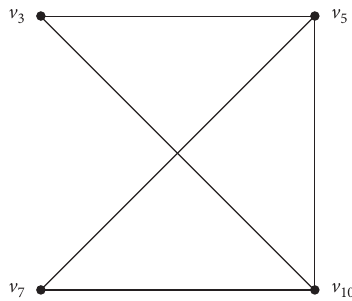
Figure 2: Graph G I ( Λ ), where Λ = < 3, 5, 7 > and I is an irreducible ideal with x